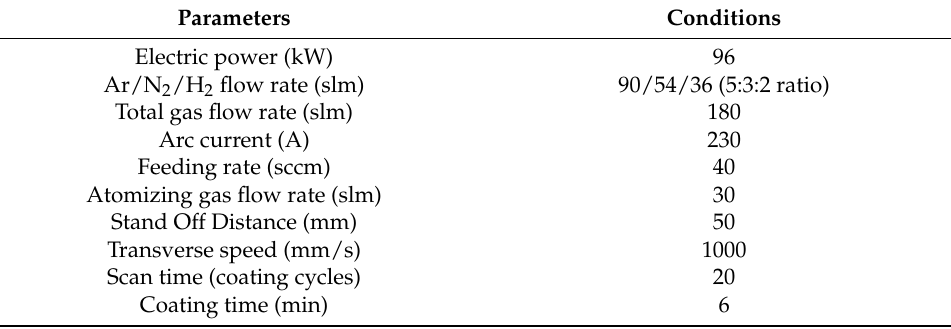
Figure 3. Schematic of the Axial III SPS system [14]. Table 2. Processing parameters for YOF coatings by SPS.